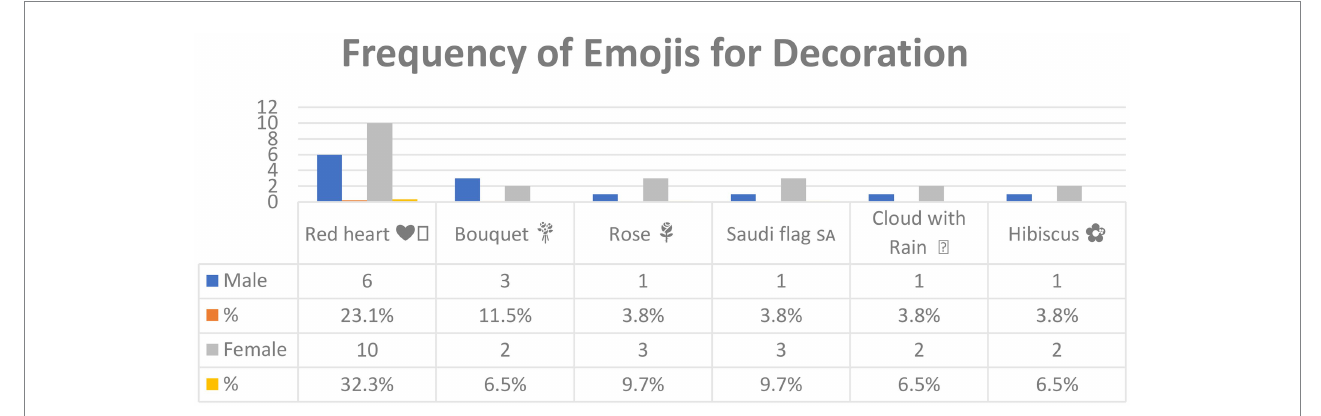
FIGURE 7 The most common emojis used for Decoration in Arabic tweets.